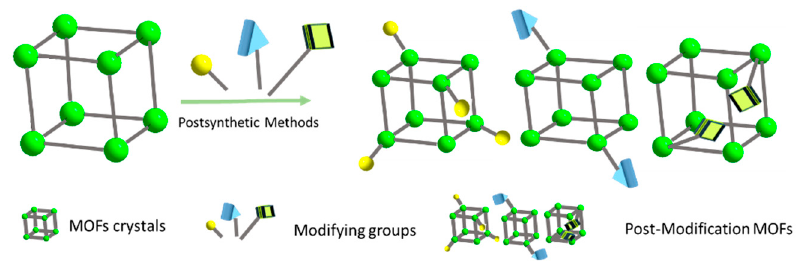
Figure 5. Schematic diagram of the post-synthetic modification of MOFs.